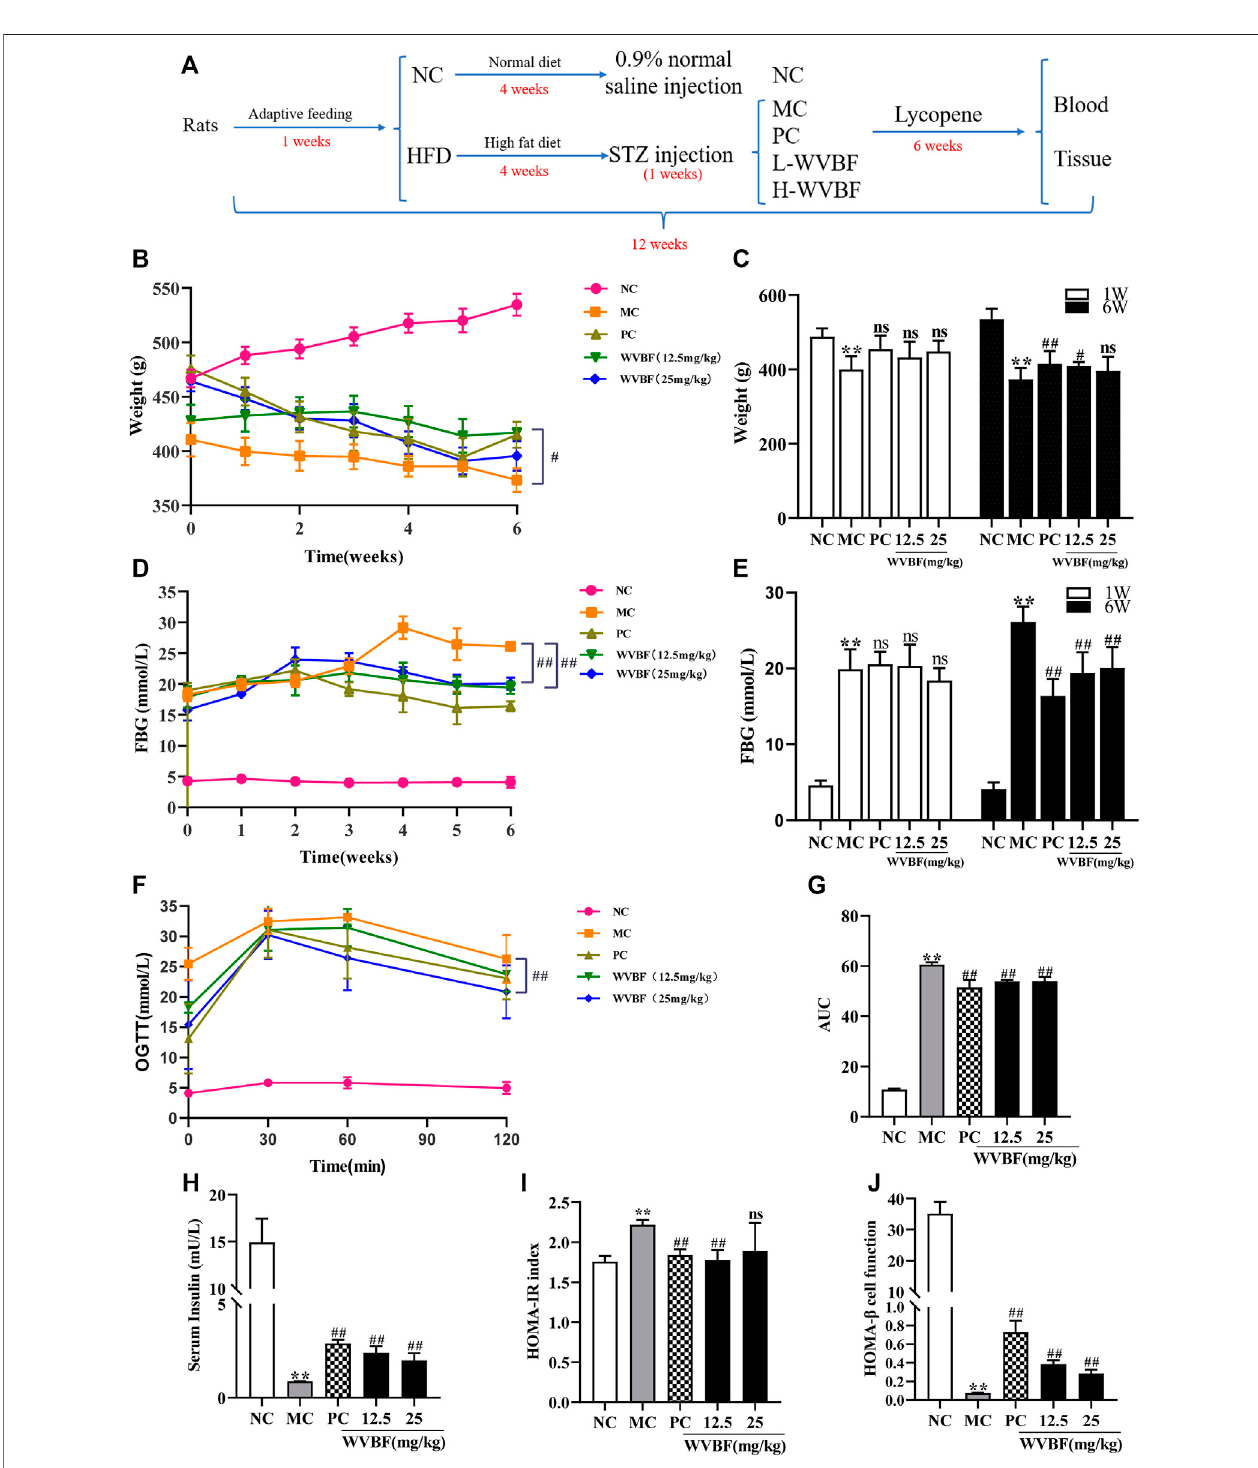
FIGURE 1| Effects ofWVBF treatment on weight,blood glucose and insulin resistance ofdiabeticrats. (A) overview of the experimental process. (B, C) The effect of WVBF on the body weight of diabetic rats. (D, E) The level of FBG from one to 6 weeks (D) and at the end of 6 weeks (E) . (F, G) The levels of blood glucose (F) and areas under curves AUC (G) in oral glucose tolerance test (OGTT) at the end of 6 weeks (H – J) WVBF intervention in fl uenced insulin sensitivity and insulin resistance in diabetic rats. HFD: high-fat diet, L-WVBF: WVBF 12.5 mg/kg, H-WVBF: WVBF 25 mg/kg, WVBF 12.5 mg/kg, NC: normal control, MC: mellitus control, PC: positive control, 12.5: WVBF 12.5 mg/kg/day, 25: 25 mg/kg/day. Date were shown as mean ± SEM; * p < 0.05, ** p < 0.01 vs . NC group; # p < 0.05, ## p < 0.01, vs . MC group. B-E, n (cid:1) 8 in each group; F-J, n (cid:1) 6 in each group.